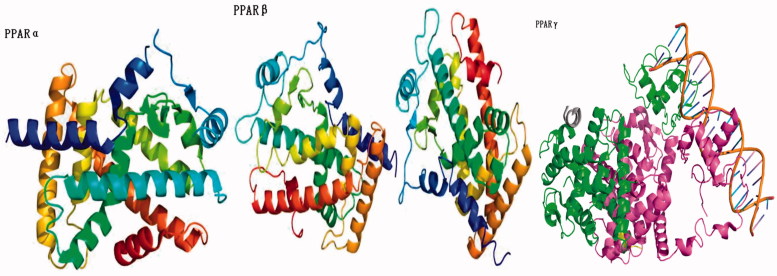
The protein structure of PPAR52–58.